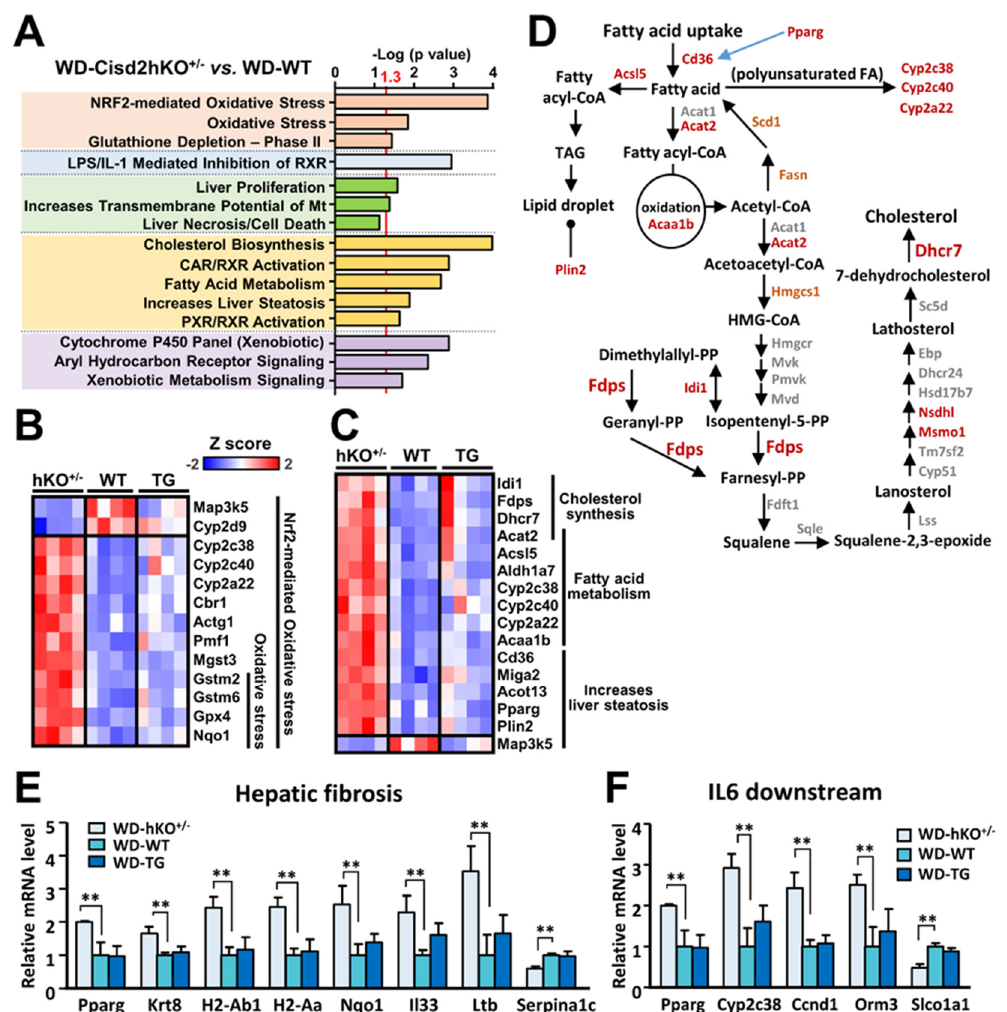
Figure 4. Functional analyses of differentially expressed genes in the livers of WD-fed mice. ( A ) Top lists from IPA using hepatic mRNA transcripts affected by hepatocyte-specific Cisd2-haploinsufficiency (Cisd2hKO +/ − ). ( B , C ) Heat maps of changes in the mRNA levels of genes related to oxidative stress ( B ) and lipid metabolism ( C ). ( D ) Cisd2hKO +/ − mice fed Western diet display altered expression of genes related to cholesterol biosynthesis. The significant genes (FDR < 0.05) are highlighted with red color. Borderline significance (FDR ≤ 0.1) of Hmgcs1, Fasn, and Scd1 are highlighted with orange color. ( E ) Expression levels of fibrosis-related genes from Tox list of ‘Hepatic Fibrosis’ in IPA ( n = 4). ( F ) Expression levels of the downstream genes of IL-6 that is predicted to be activated in Cisd2hKO +/ − mice by IPA upstream regulator analysis (n = 4). WT control group was set as 1. Data are presented as mean ± SD. * p < 0.05; ** p < 0.005.